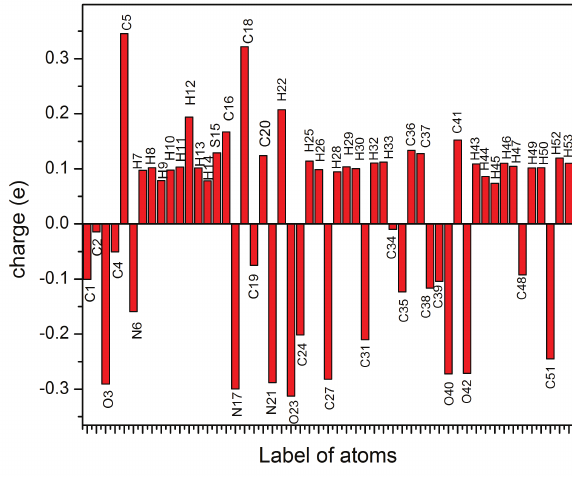
Figure 3: Natural charge distribution chart of the title